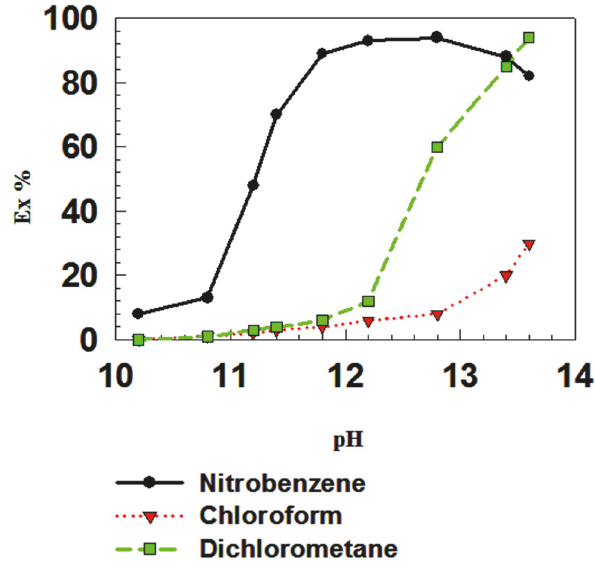
Figure 2: Effect of the organic solvent (nitrobenzene, dichloromethane, or chloroform) on the extraction percentage of Cd 2+ with H 8 L. H L = 5 × 10 −4 M; aqueous phase [metal ion]: = 8 ( e ) 5 × 10 −5 M. O/A = 1; succinic acid = 0.01 M; and buffer solution, T = 25 ∘ C.